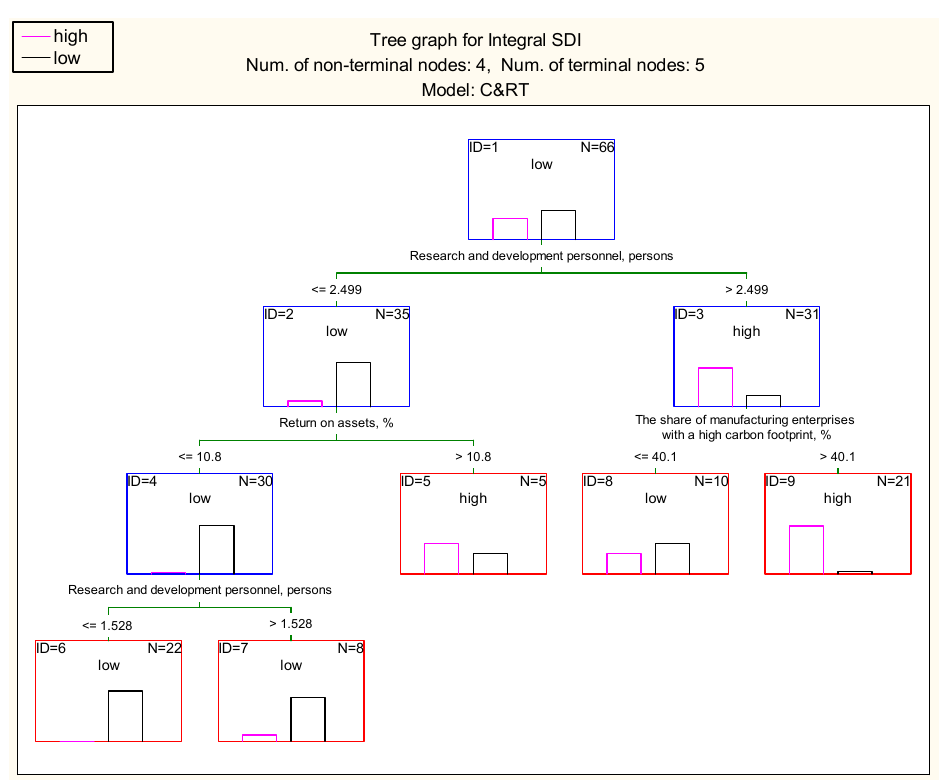
Figure 4. Classification tree to identify patterns of sustainable development of innovation mesosys- tems in industry (based on private indicators of mesosystem development).